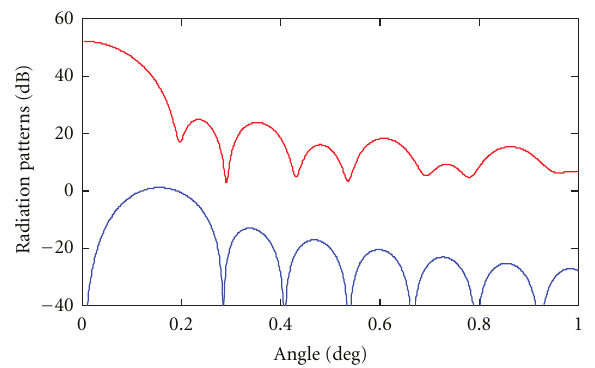
Figure 8: Radiation patterns of terahertz-design FZPA-T-150 versus angle θ : copolar radiation pattern (red line) and cross-polar radiation pattern (blue